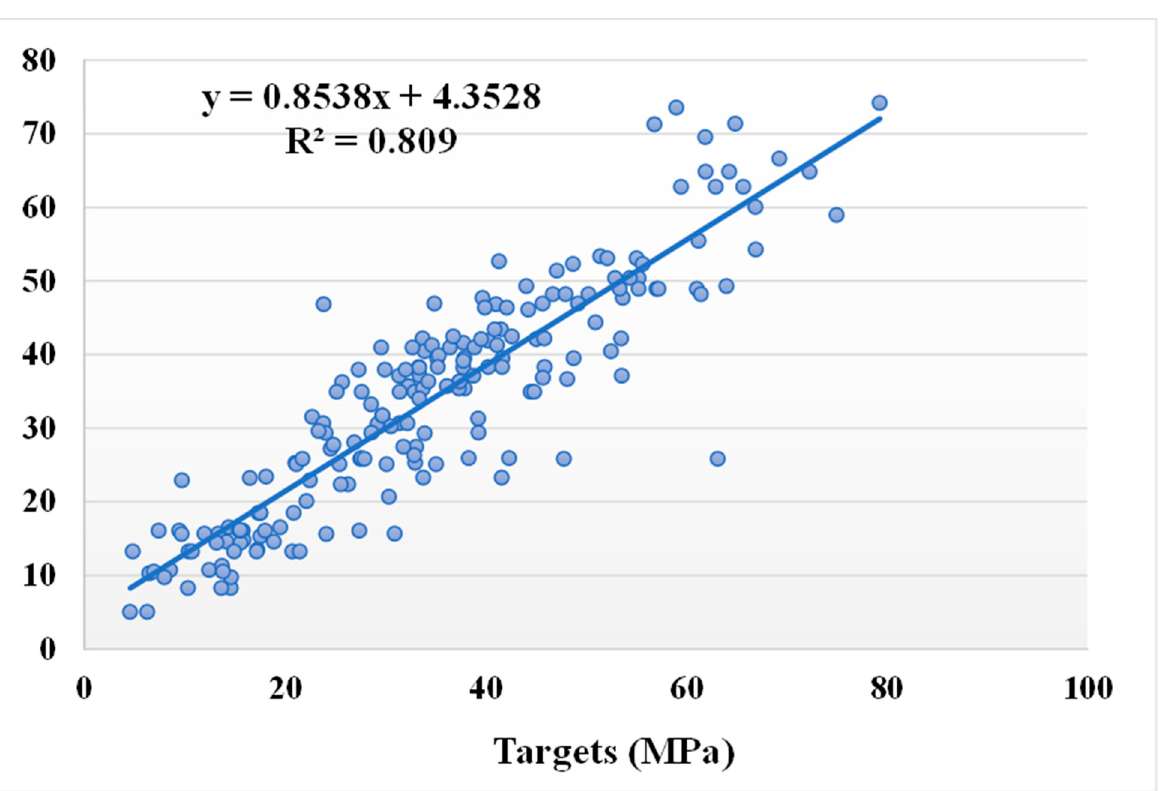
Figure 8. Distribution of actual and predicted values along with the errors for the GEP model.